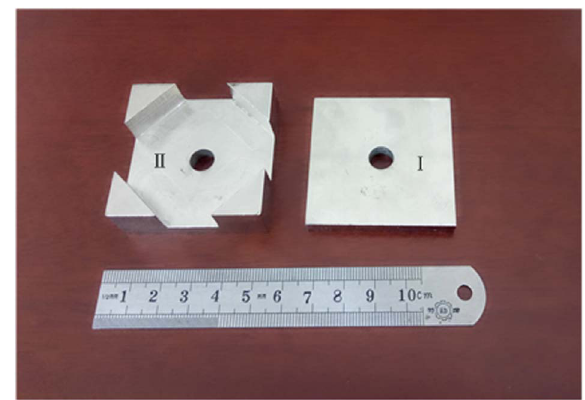
Figure 6. Fabricated square-plate radiators I and